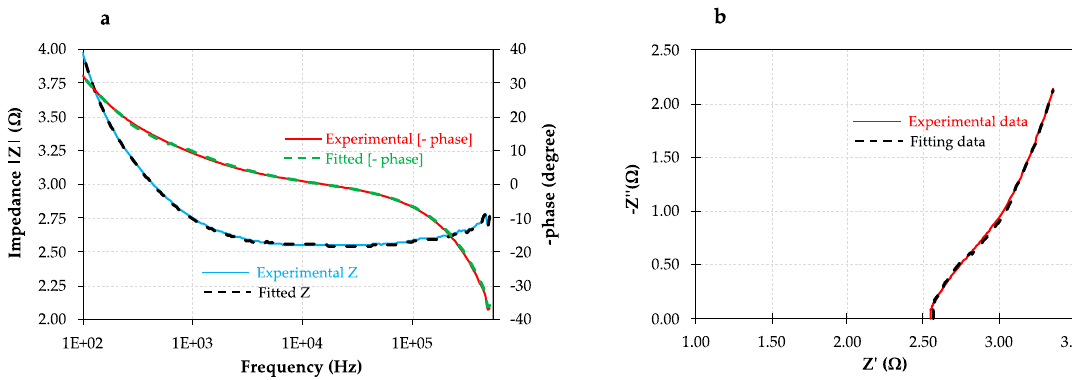
Figure 7. Electrochemical impedance spectroscopy ( EIS ) study of the unmodified membrane including experimental (continuous line) and fitting data (dotted lined): ( a ) Bode plot; ( b ) Nyquist plot.